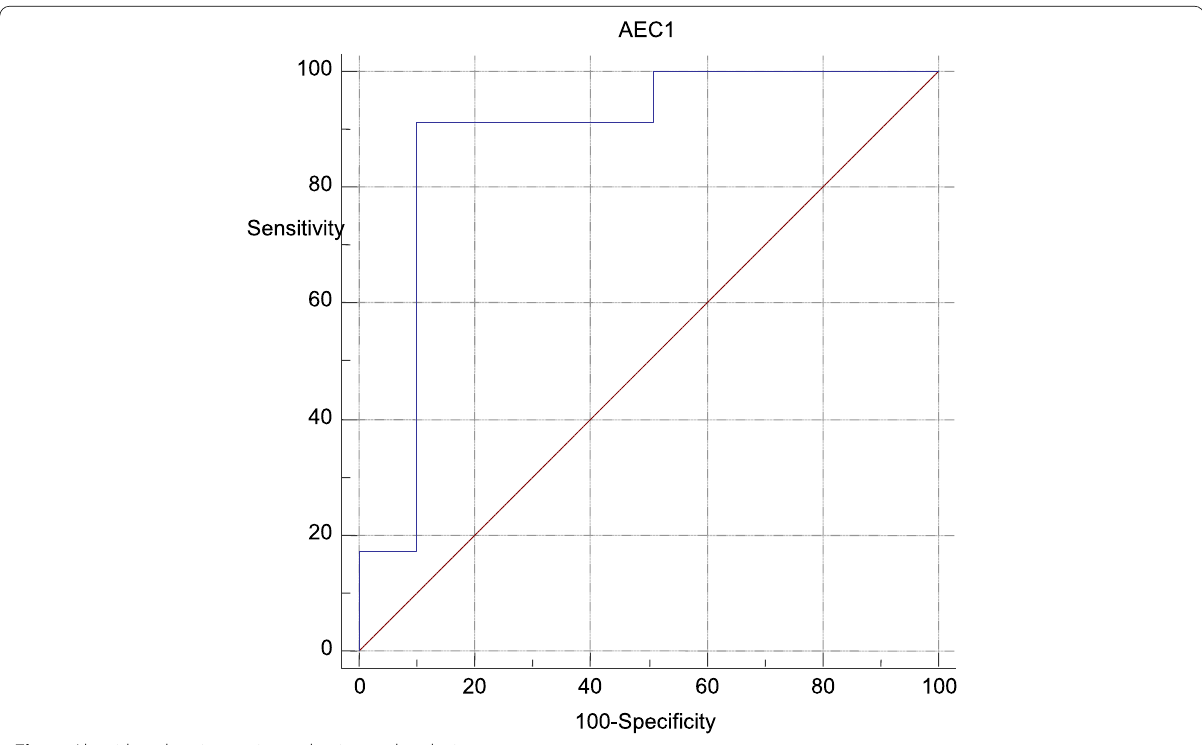
Fig. 1 Algorithm showing patient selection and